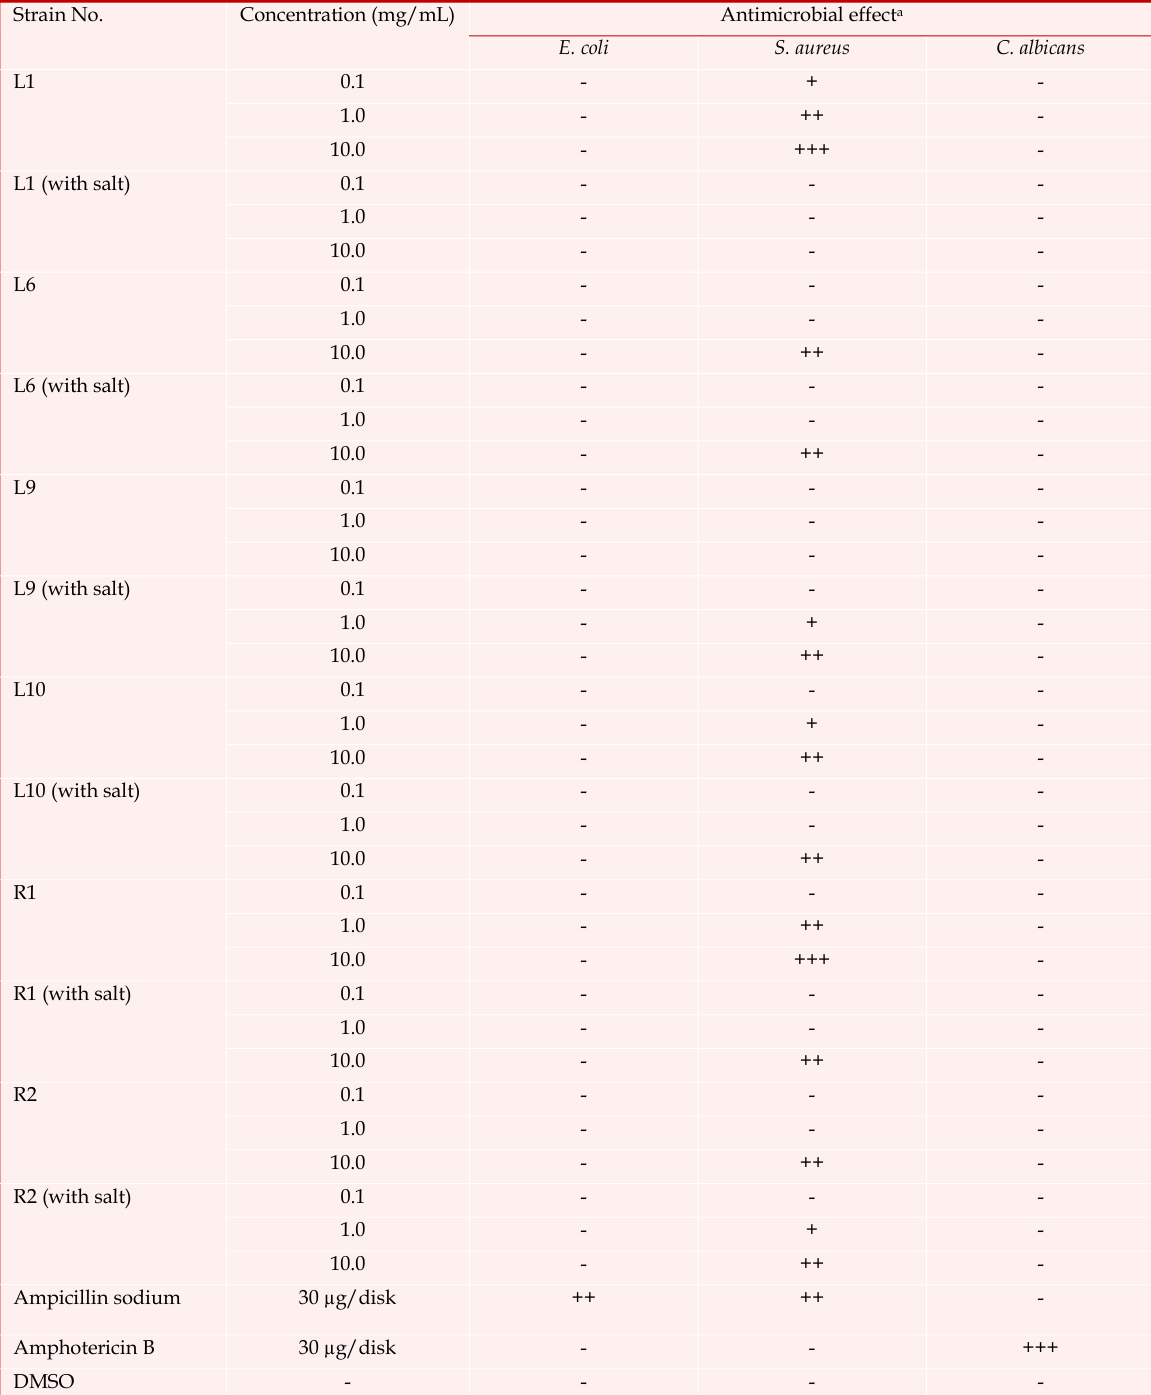
Antimicrobial activities of ethyl acetate extracts of endophytic fungi from R. madaio Strain